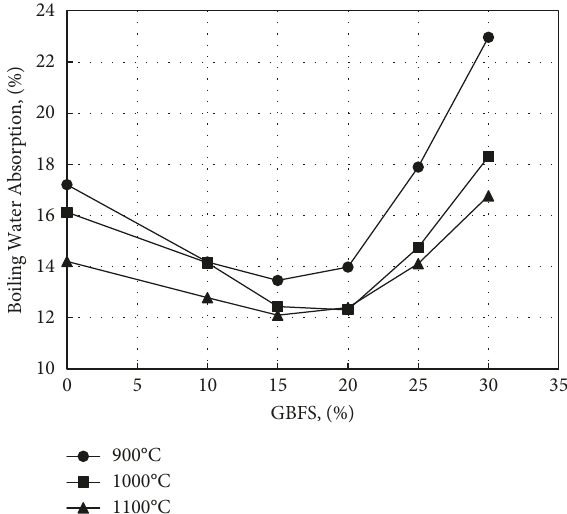
Figure 8: Effect of GBFS addition on boiling water absorption.